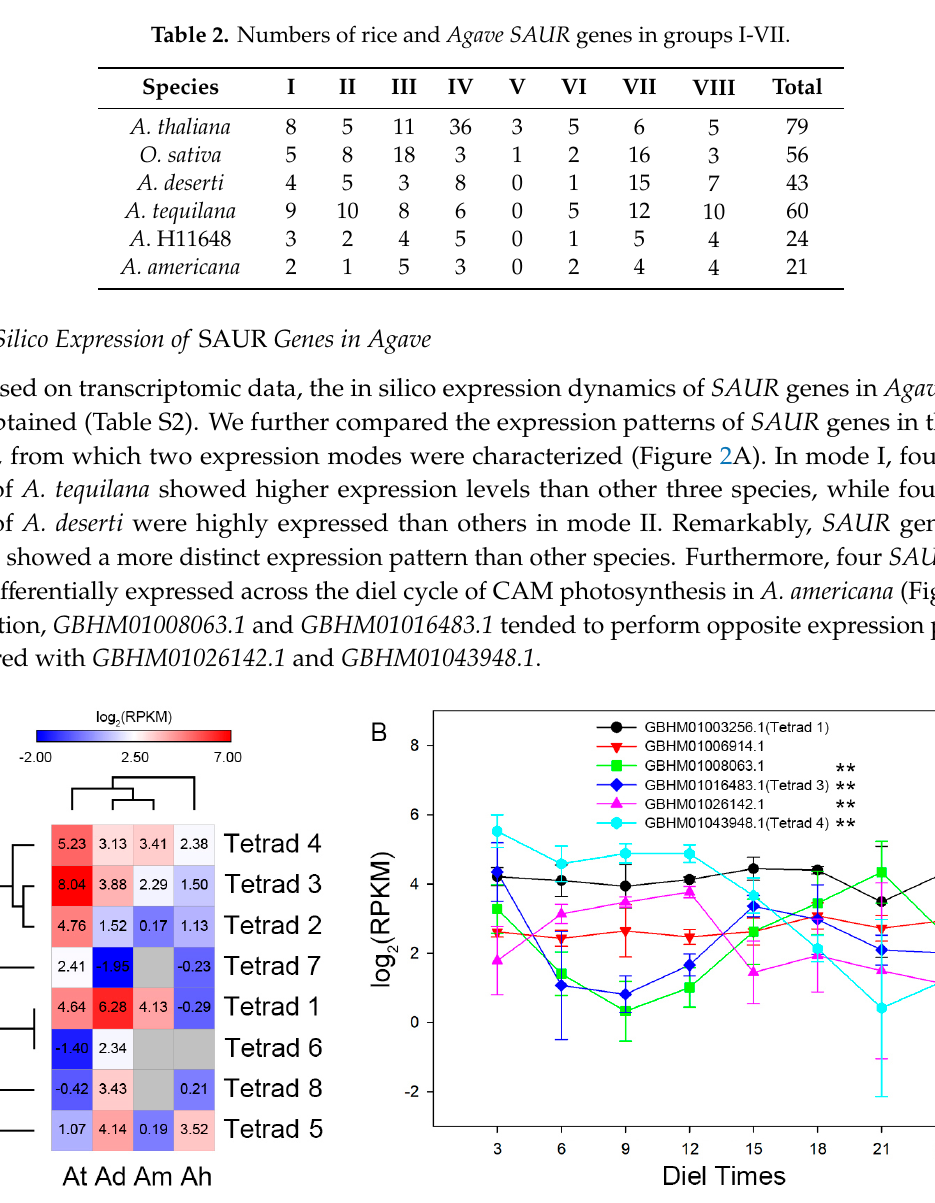
Figure 2. ( A ) The in silico expression of SAUR tetrad homologs in the leaves of A. deserti (Ad), A. tequilana (At), A. H11648 (Ah) and A. americana (Am) according to previous studies [31,33,34]. Blanked squares represent no expression data. ( B ) The in silico expression of SAUR genes across the diel cycle of CAM photosynthesis in A. americana according to a previous study [34]. The numbers of x -axis represent diel times 3, 6, 9, 12, 15, 18, 21 and 24 h from the beginning of the light period. Differentially expressed SAUR genes were highlighted with **. Error bars represent standard deviations.